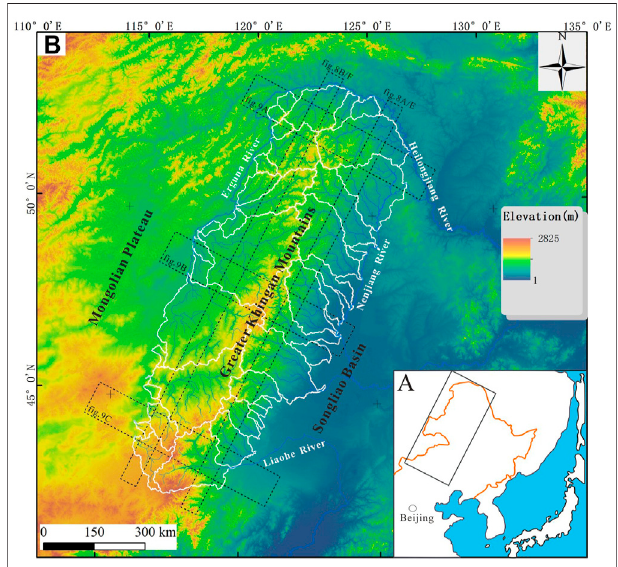
FIGURE 1 | (A) Location of the study area in East Asia; (B) Hillshade of 90 m digital elevation model produced from the Shuttle Radar Topography Mission,bluelines showmajorrivers,whitelines showmajordrainage